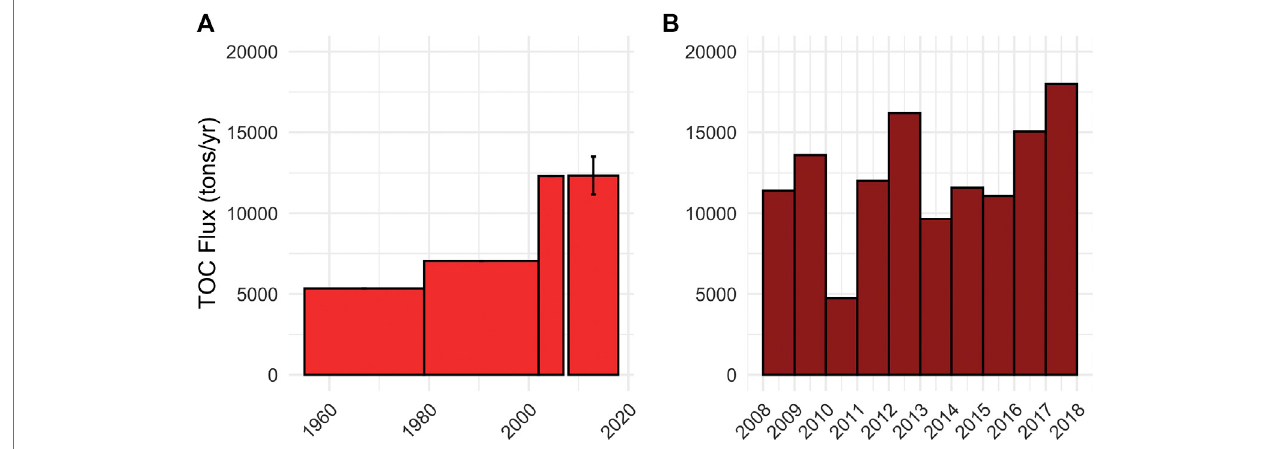
FIGURE8| Estimationoftotalorganiccarbon fl uxestotheocean(metrictonsTOC year − 1 )fromthe9 kmstudysection (A) overfourtimestepsfrom1955to2018 and (B) over annual time steps from 2008 to 2018. The error bar shows standard error.